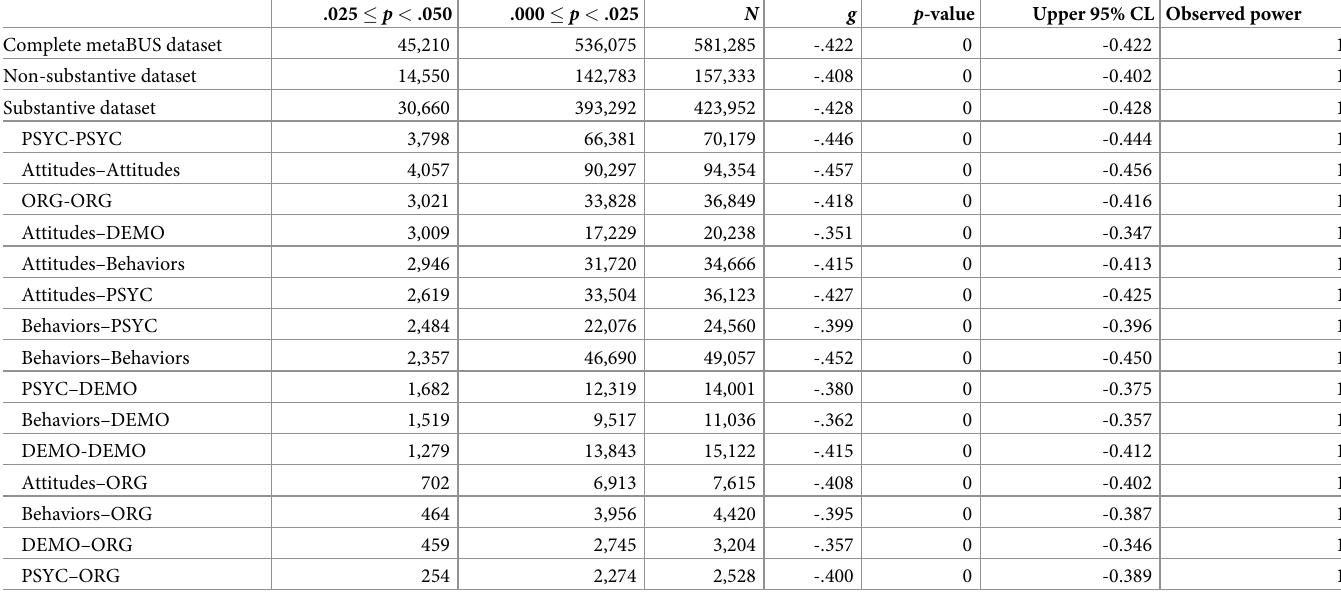
Table 6. Evidential value results according to critical bin comparisons